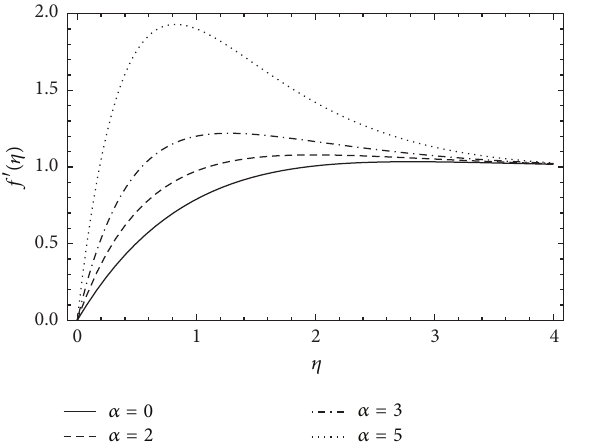
Figure 4: The influence of the rotation parameter 𝛼 on 𝑓 󸀠 (𝜂) for 𝜆 = 1 , ℏ = −0.1 .